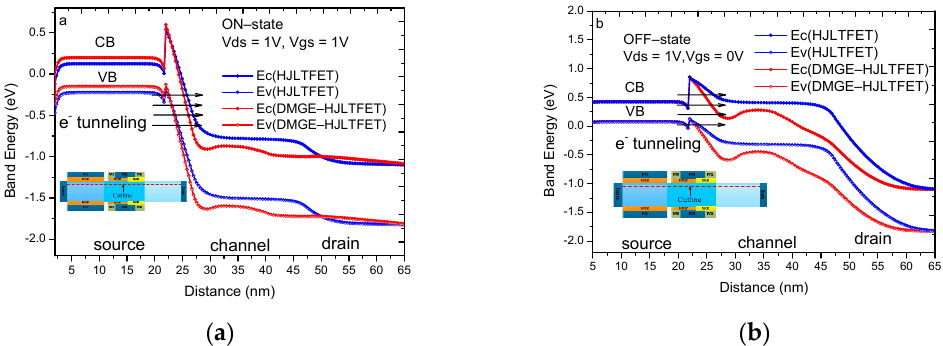
Figure 3. ( a ) The ON-state energy band diagram of the HJLTFET and DMGE-HJLTFET; ( b ) the OFF-state energy band diagram of the HJLTFET and DMGE-HJLTFET.